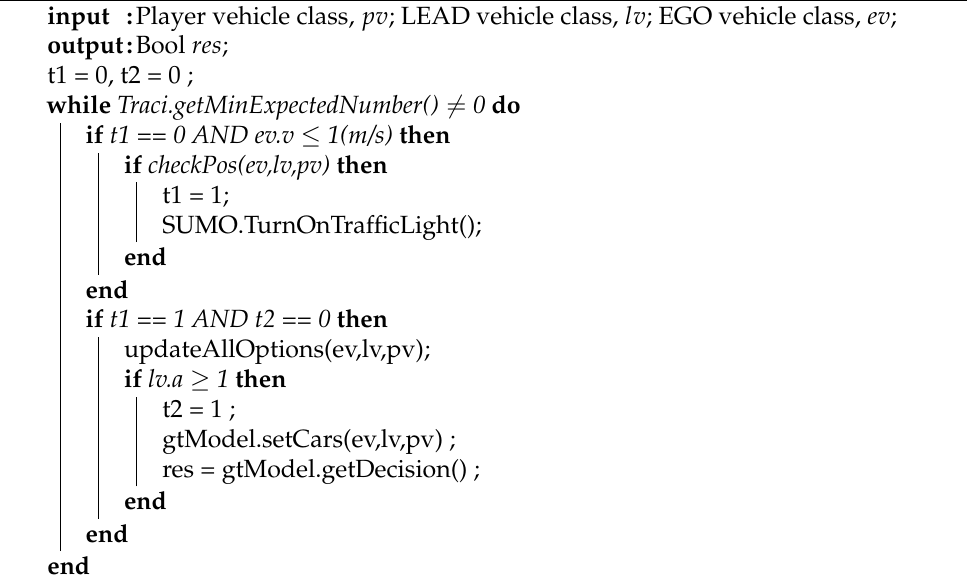
Algorithm 2 Proposed game theory-based decision-making